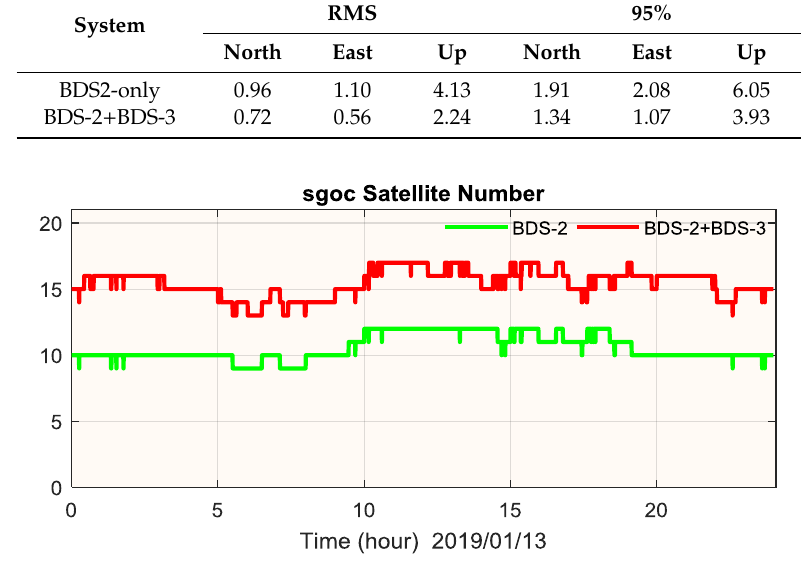
Figure 8. Visible satellite number at station SGOC for an elevation angle mask of 10°on 13 January 2019.